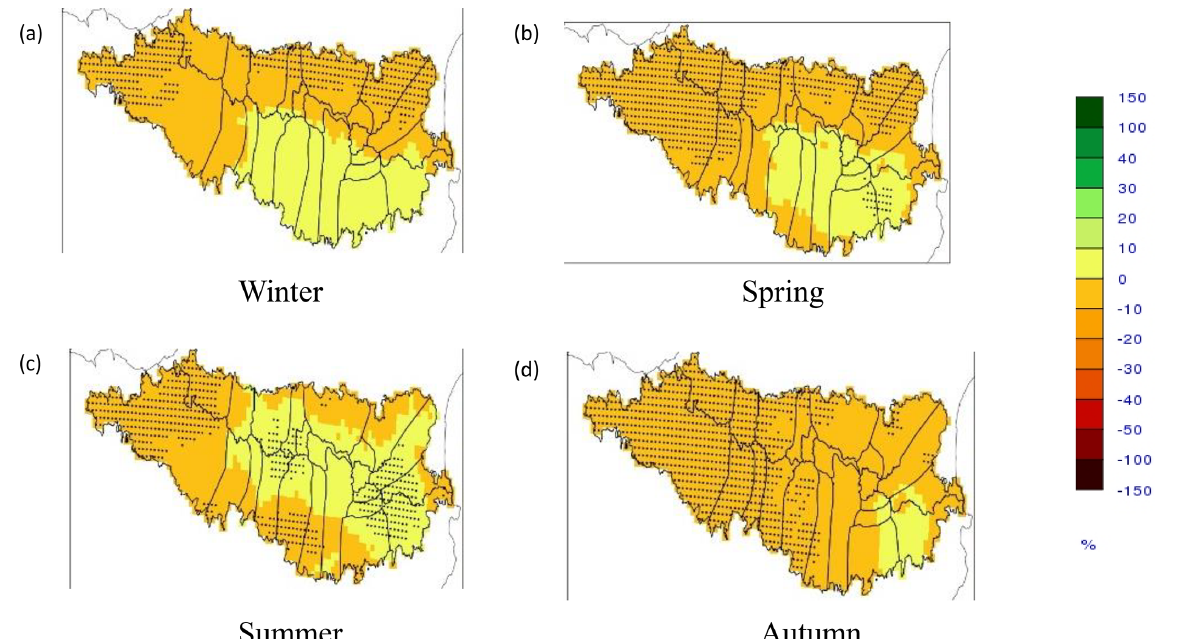
Figure 11. The same as Fig. 4 but for relative anomaly of accumulated precipitation (%).